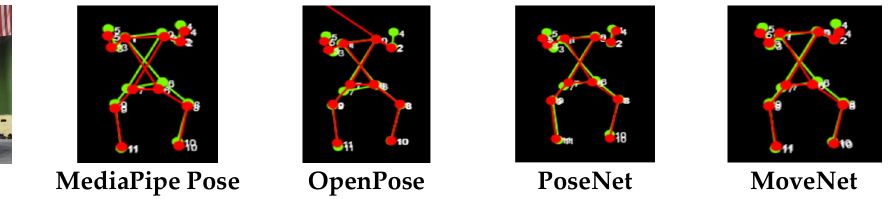
Figure 6. Sample video frame and detection result of Action 12 (squat). Green lines indicate the ground truth, red lines indicate the tested HPE library.